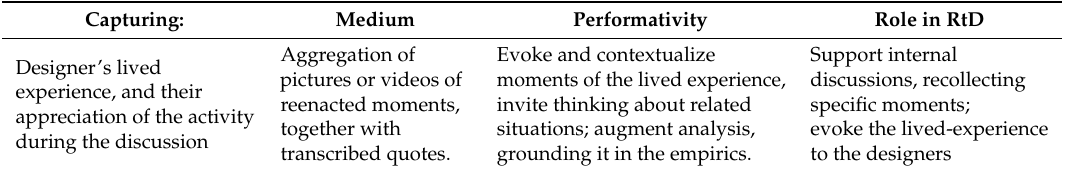
Table 3. Overview of the SomaBoards’ core qualities and what they